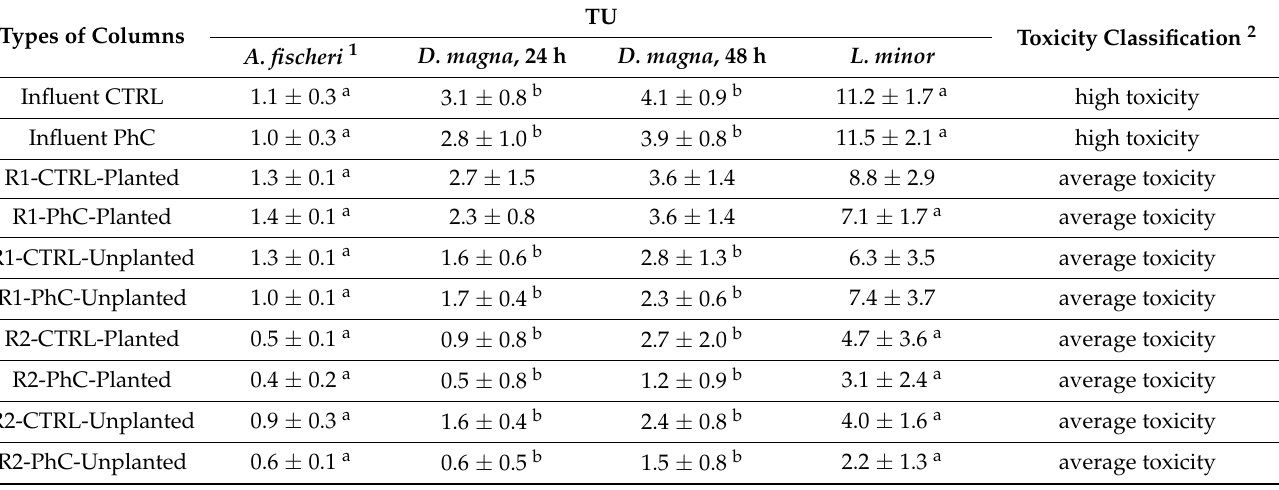
Table 4. The TU value and toxicity classification of wastewater from